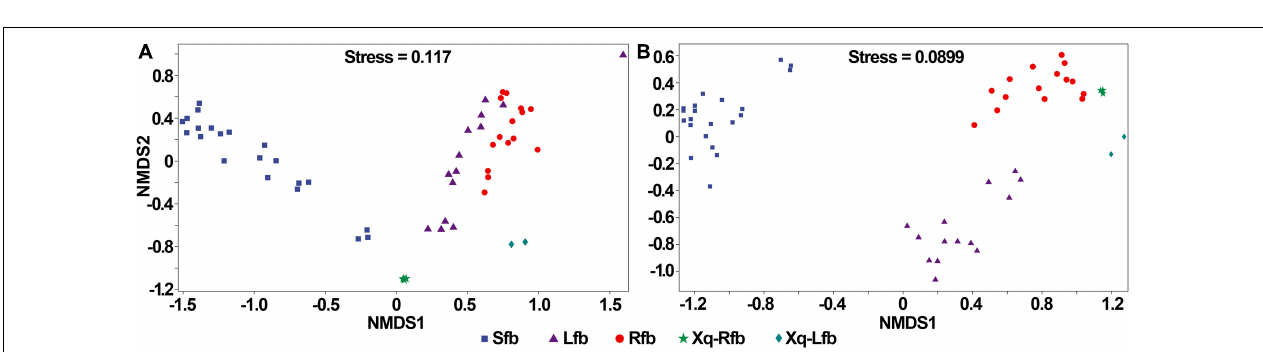
FIGURE 6 | Redundancy analysis (RDA) showed the relationship of microbial community and physicochemical factors in the brewing process of rice-flavor baijiu. Bacteria (A) , and fungi (B) .